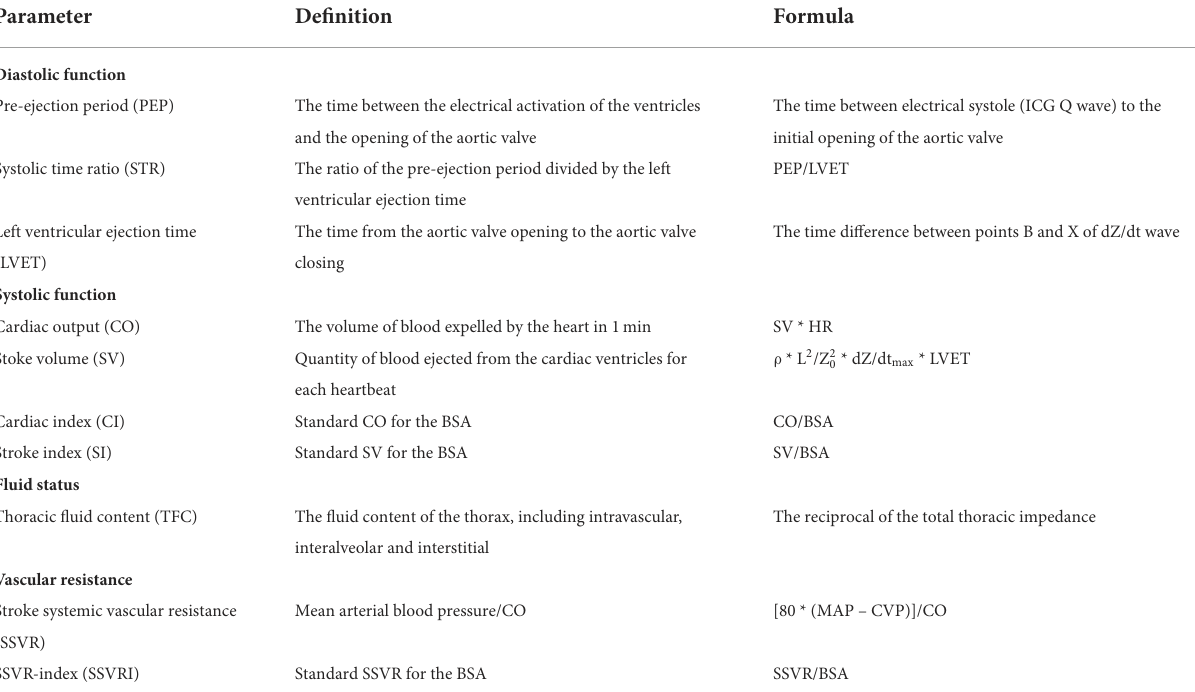
TABLE 1 Parameters assessed in impedance